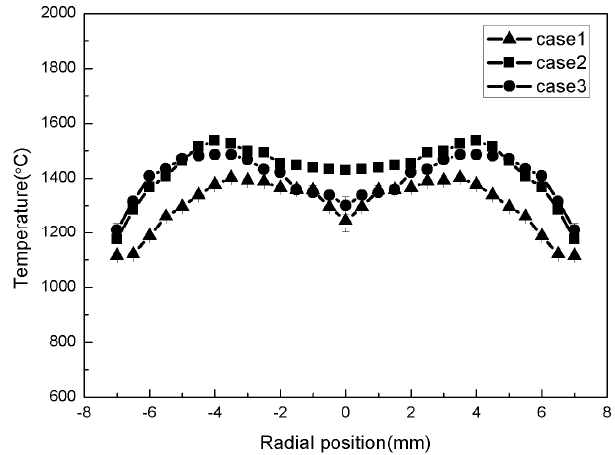
Figure 4. Variation of measured flame temperature with radial distance for three flames.